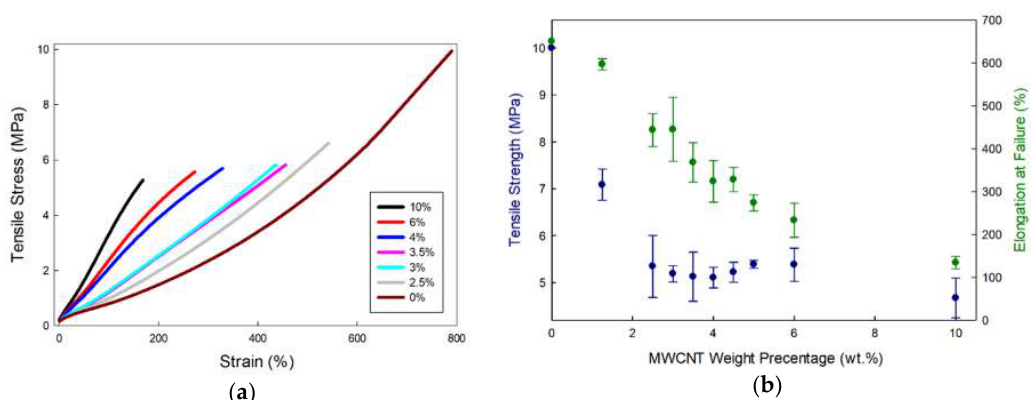
Figure 5. ( a ) stress-strain curves of various CNT concentration based VMQ; ( b ) the resultant tensile strength and strain at failure of these composites. For comparison, 10 wt.% In comparison, CB/VMQ has tensile strength of ~ 5 MPa and strain-at-failure of 250%.